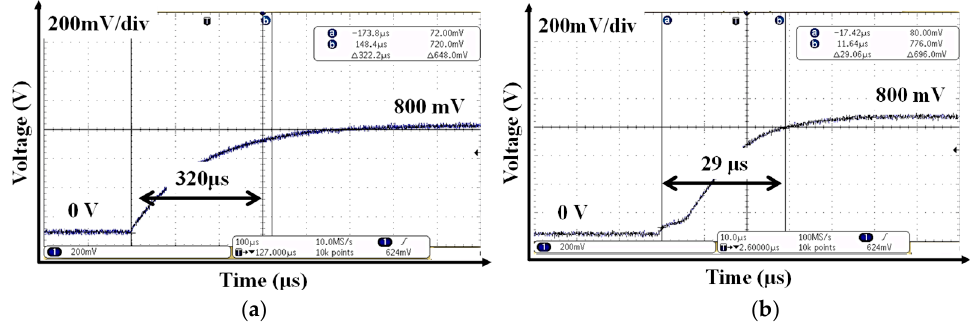
Figure 33. Measured output of the LDO ( a ) with and ( b ) without a fast settling technique.